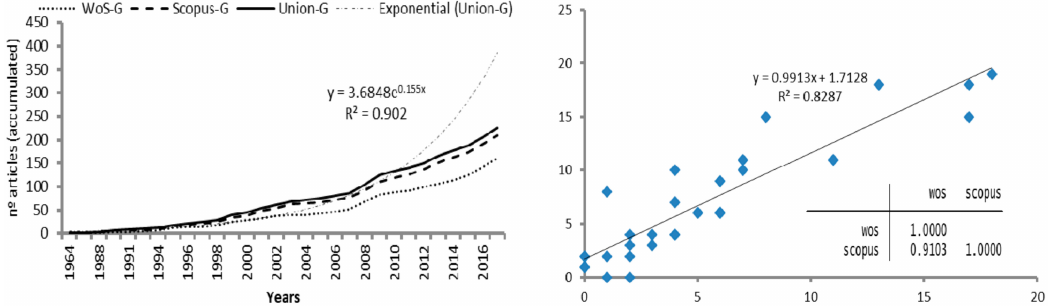
Figure 3. Growth and Correlation of articles published in WoS and Scopus on Sustainable Water